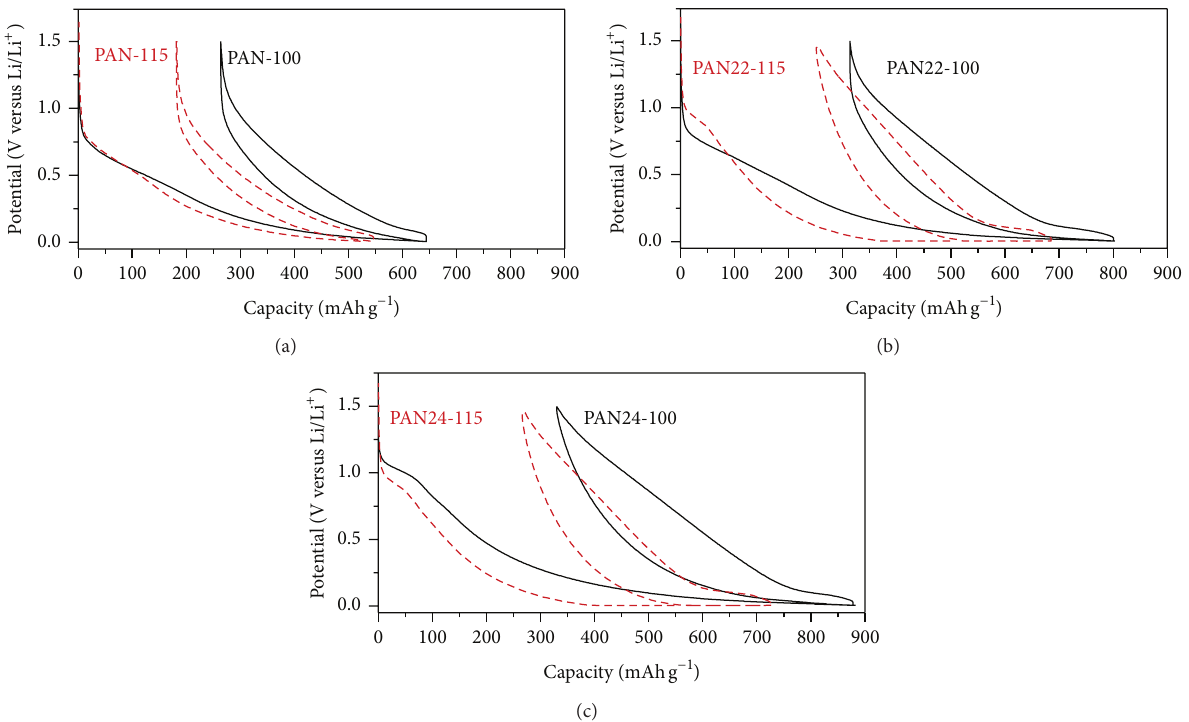
Figure 6: Galvanostatic insertion/deinsertion of lithium into hard carbons produced at 1000 and 1150 ∘ C from PAN (a), PAN22 (b), and PAN24 (c).